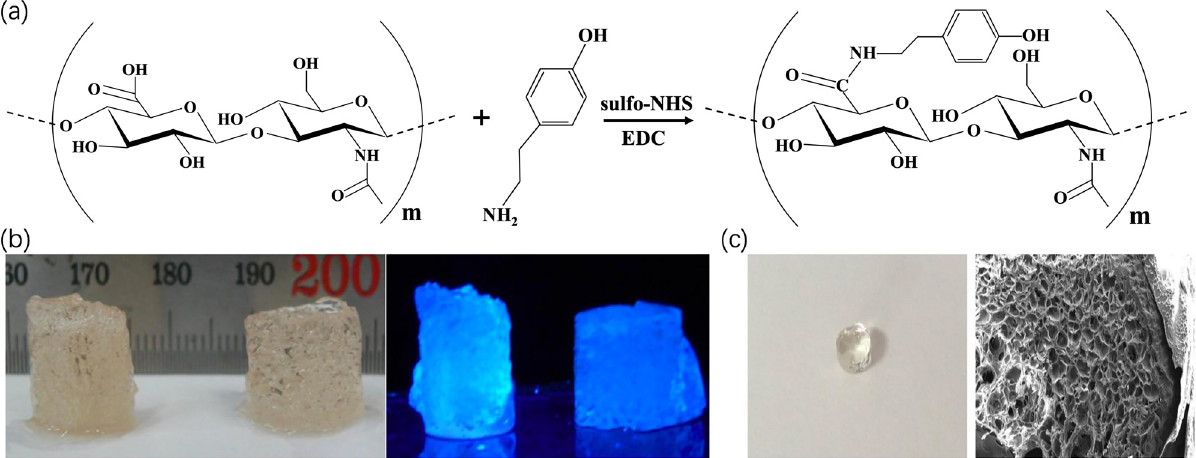
Figure 3: ( a ) The synthetic route of tyramine - modi fi ed HA. ( b ) The tyramine - modi fi ed HA hydrogels with and without exposure to UV light [ 66 ] . ( c ) The hydrogels composed of HA - tyramine and chondroitin sulfate - tyramine [ 67 ]